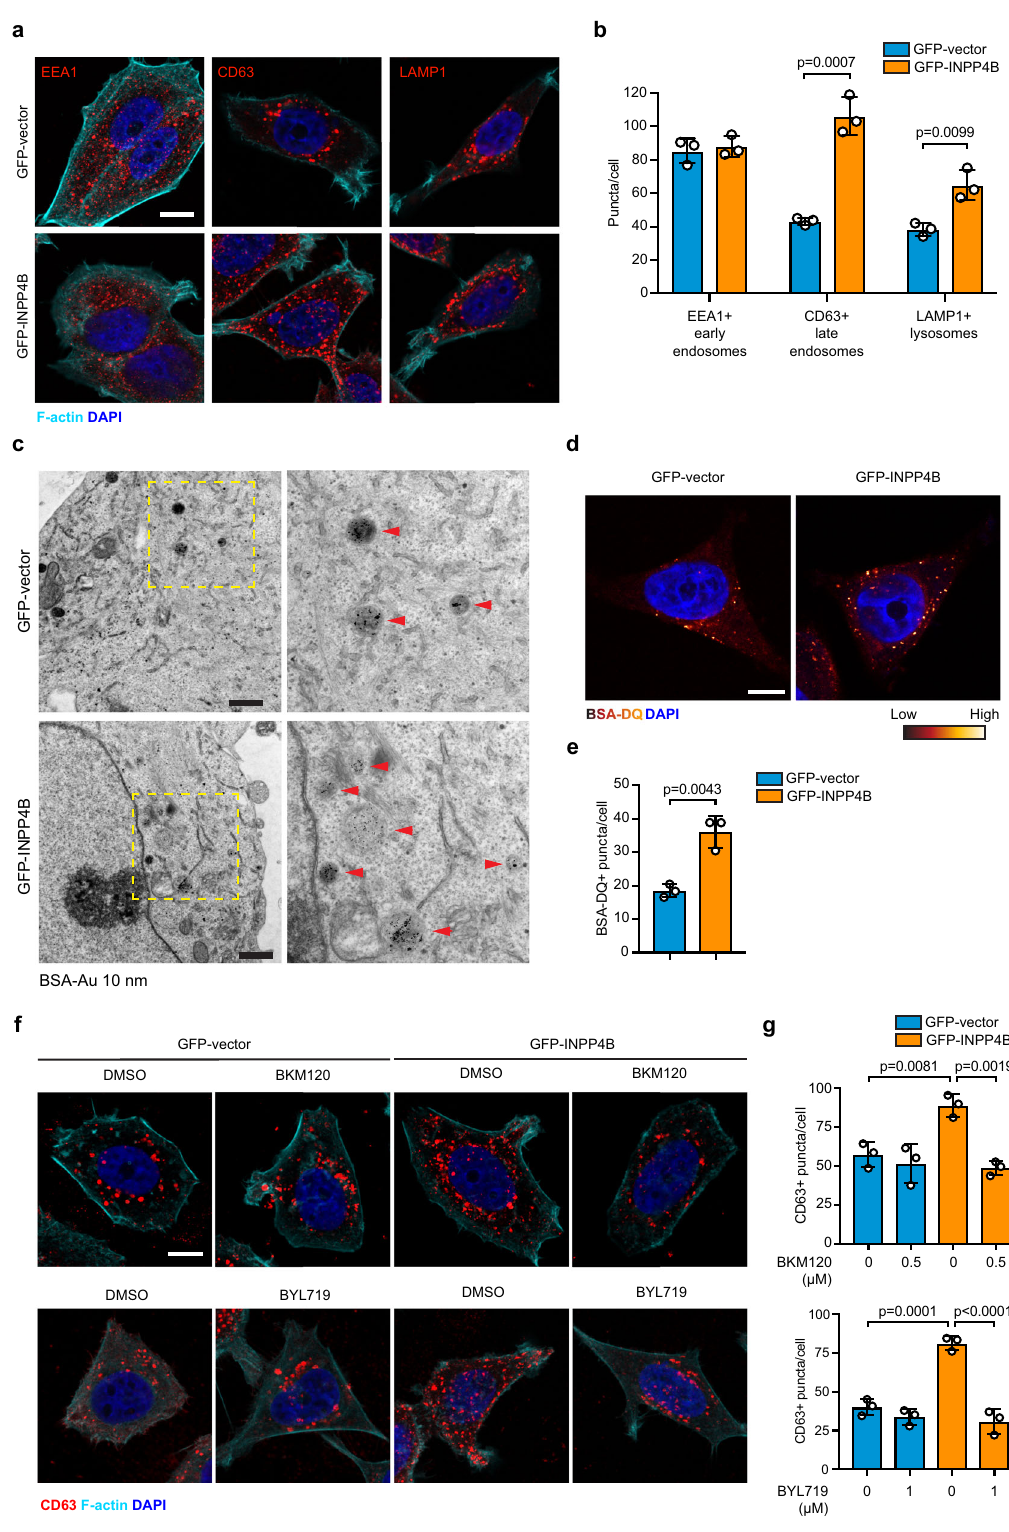
versus GFP-vector expressing MCF-7 cells by nanoString RNA pro fi le analysis, which revealed altered expression of several Wnt/ β -catenin pathway genes (Fig. 6a). Wnt/ β -catenin signaling reg- ulates mammary epithelial cell proliferation and migration and is hyperactivated in >50% of human breast cancers 37,38 . Increased mRNA expression of the Wnt/ β -catenin target genes AXIN2 (1.8- fold), LEF1 (5.6-fold), DKK1 (3.3-fold), and MYCN (2-fold) in